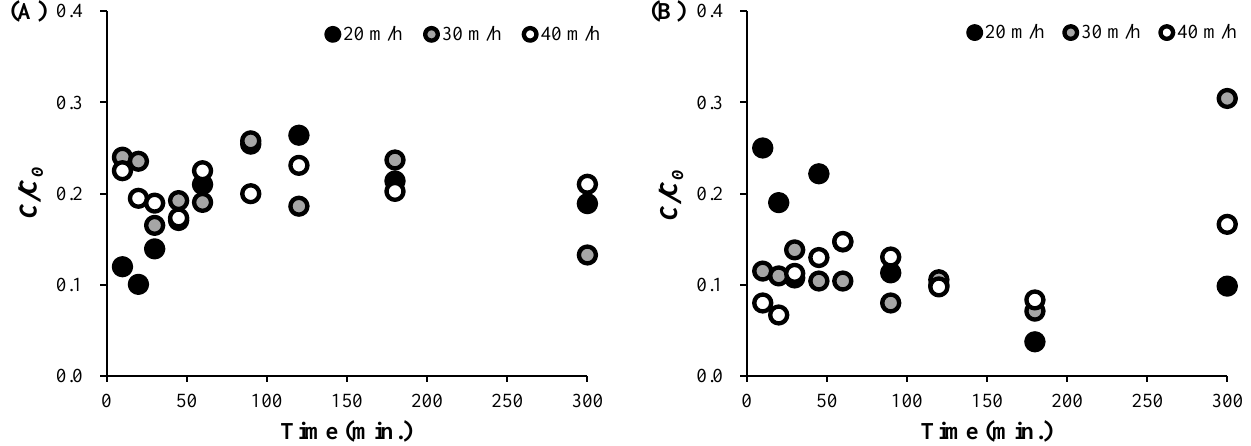
Figure 2. The time evolution of SS concentration in the outlets of ( A ) the sedimentation chamber and ( B ) the filtration chamber.